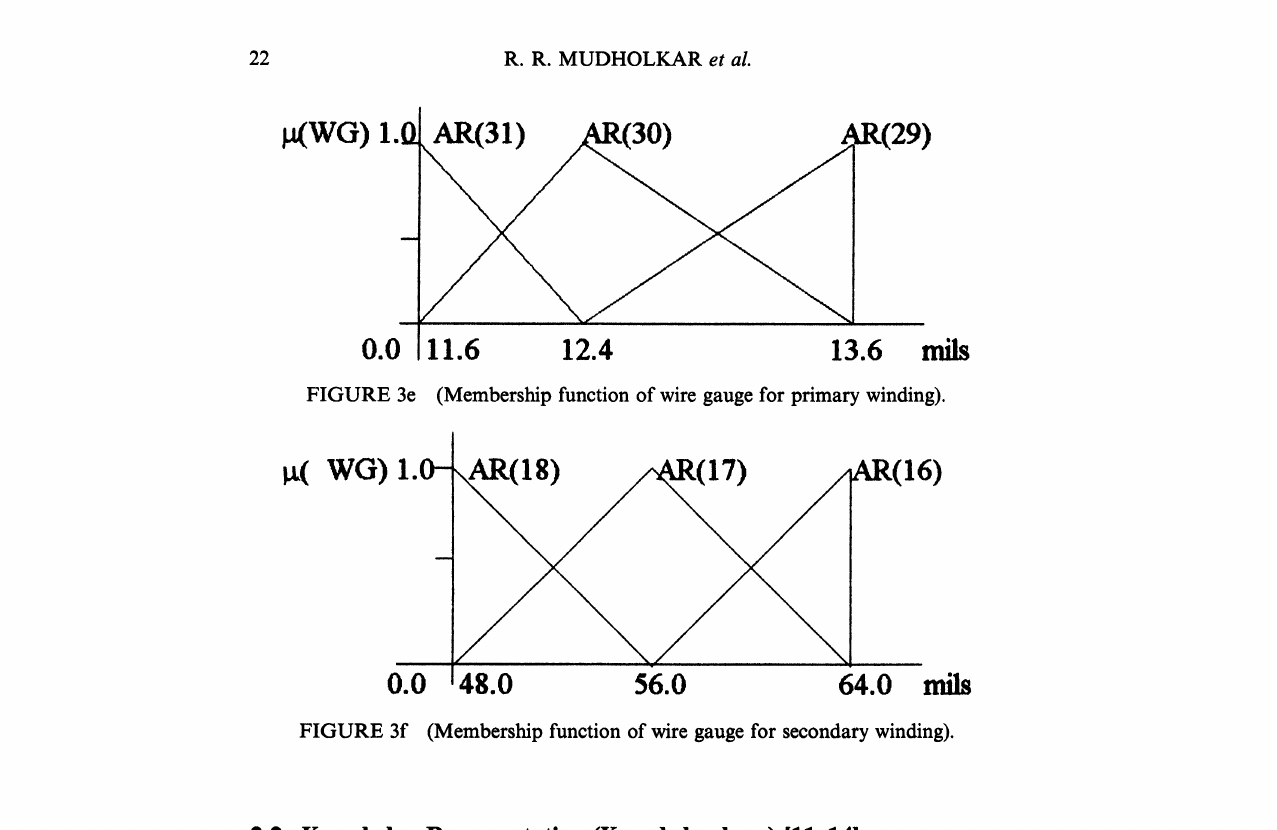
FIGURE 3f (Membership function of wire gauge for secondary